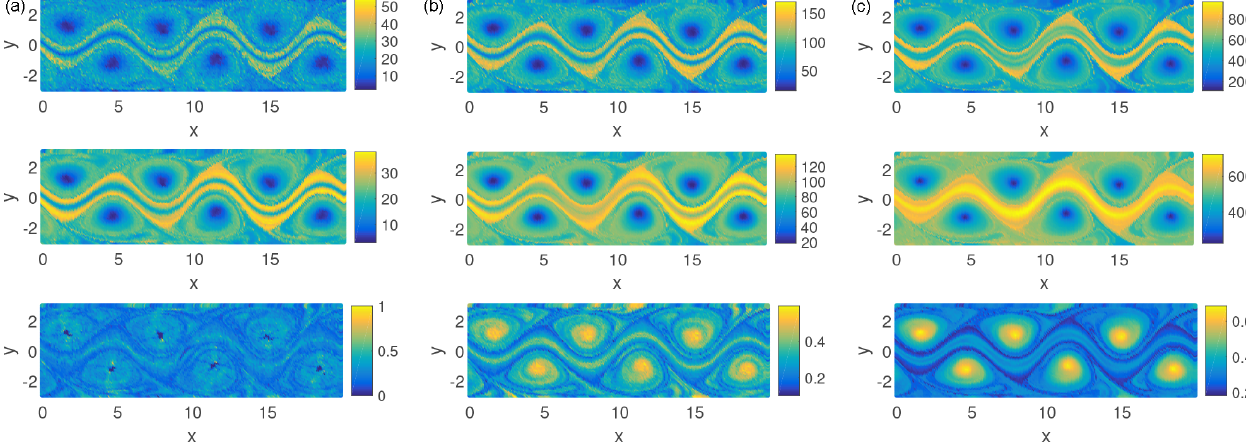
Figure 1. Network measures for high-resolution initial conditions (case i) in the Bickley jet for (cid:15) = 0 . 1 (a) , (cid:15) = 0 . 2 (b) , and (cid:15) = 0 . 5 (c) . From top to bottom: node degrees d and (cid:104) d (cid:105) nn and clustering coefficient C .